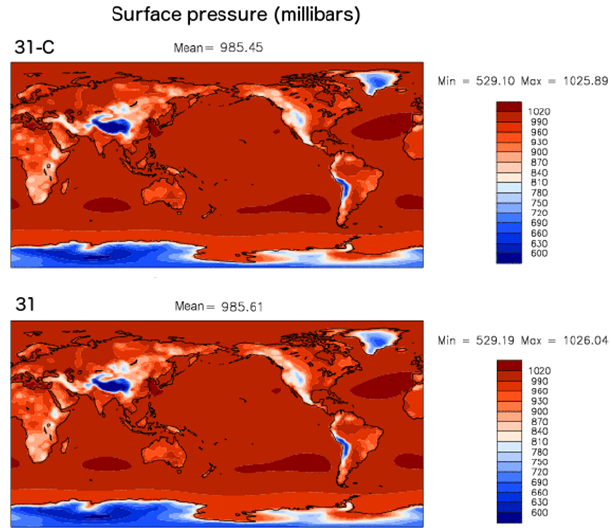
Figure 20. Horizontal contour plot of DJF (December–January– February) means for surface pressure (PS) from 2006 to 2099 for ensemble member 31. The data in the top subplot have undergone lossy compression (i.e., 31-C) and the bottom subplot contains the original data. Table 3. Subset of AMWG diagnostics set 1: annual means global. RESTOM and RESSURF are AMWG-DP-derived variables for the top-of-model residual energy balance and the surface residual en- ergy balance, respectively. RMSE indicates the root mean squared error. Units are Wm − 2 . Variable Compressed Original Difference